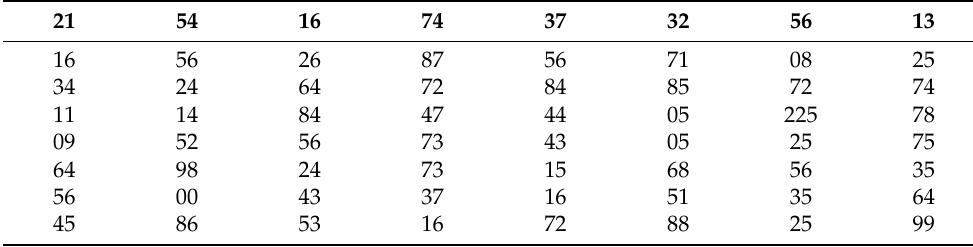
Table 10. Image coding hidden color-difference quantization.